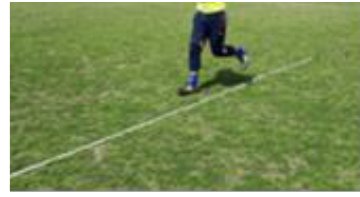
Figure 2. Triple hop